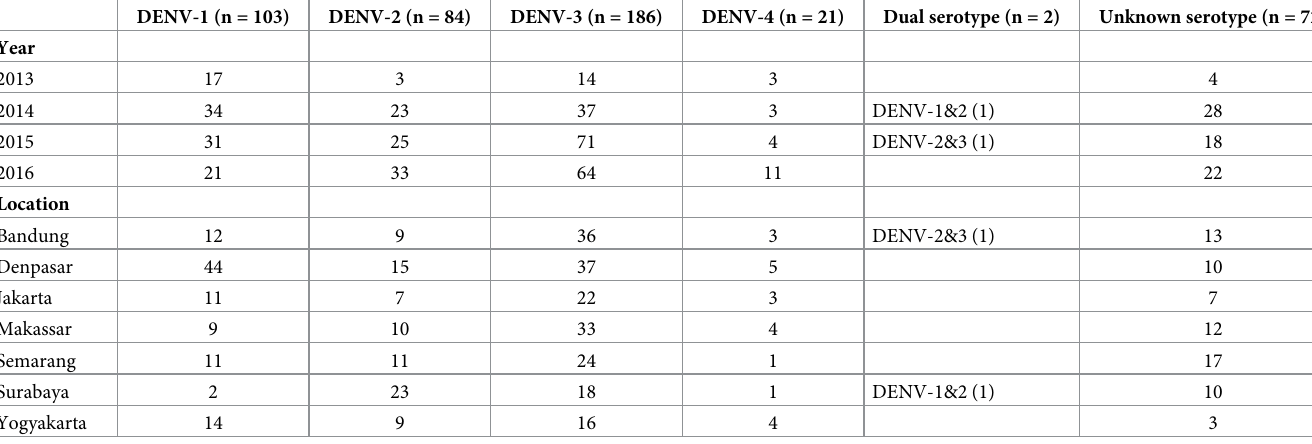
Two patients that had two different serotypes are not included in the individual DENV serotype